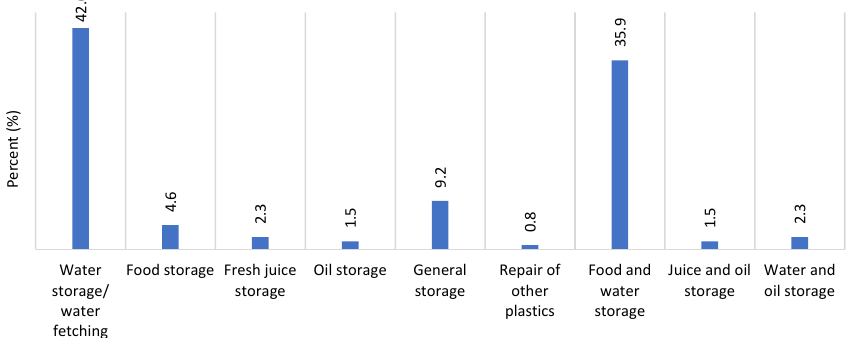
Fig. 3: Re-use methods of plastic items in Watamu Fig. 3: Re‐use methods of plastic items in Watamu ward